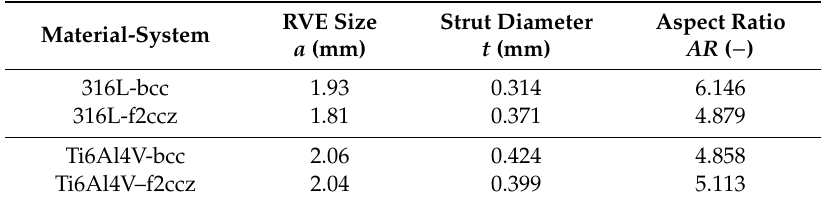
Table 5. Experimentally determined RVE sizes and strut diameters and related aspect ratios for all types of lattice specimens considered.